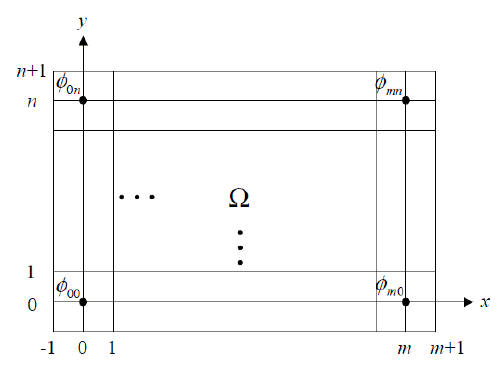
Figure 2. The relation schema of interpolation grid The node value of the interpolation grid is the interpolation coefficient to the seed’s points. The interpolation problem can be represented as finding the optimized interpolation grid Φ .As figure2 shown, the node value denote as follows;